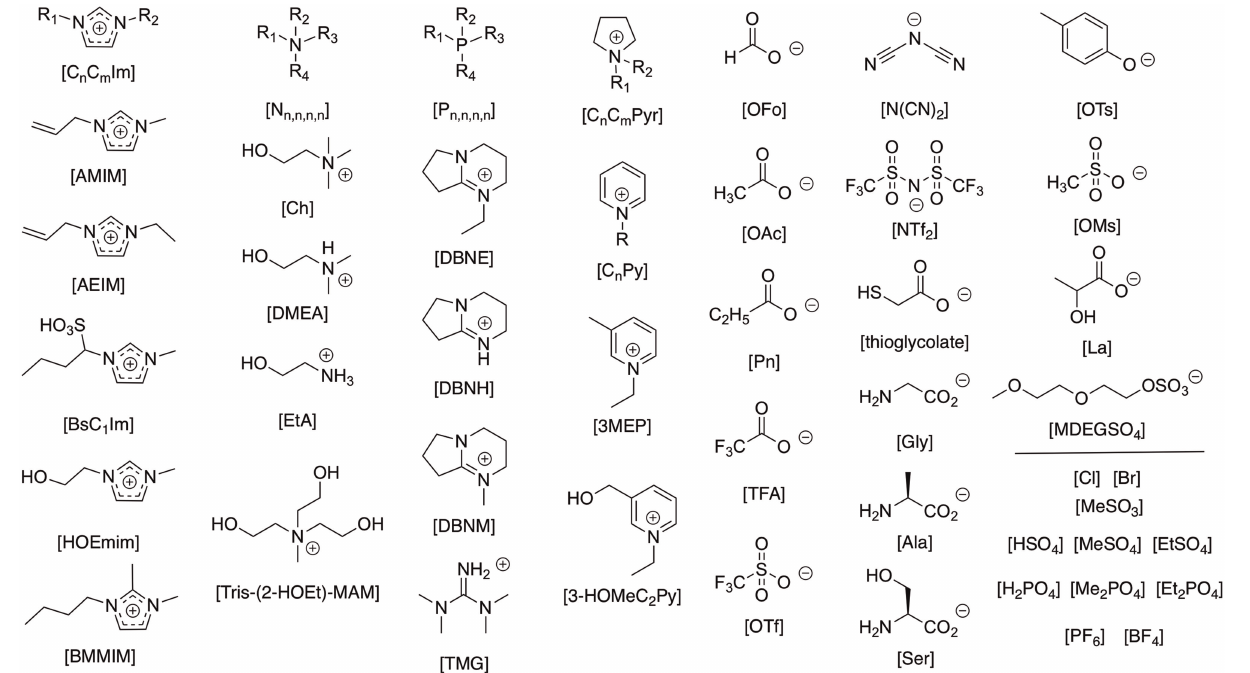
FIGURE 1 | Representative ionic liquid cation and anion structures presented throughout the